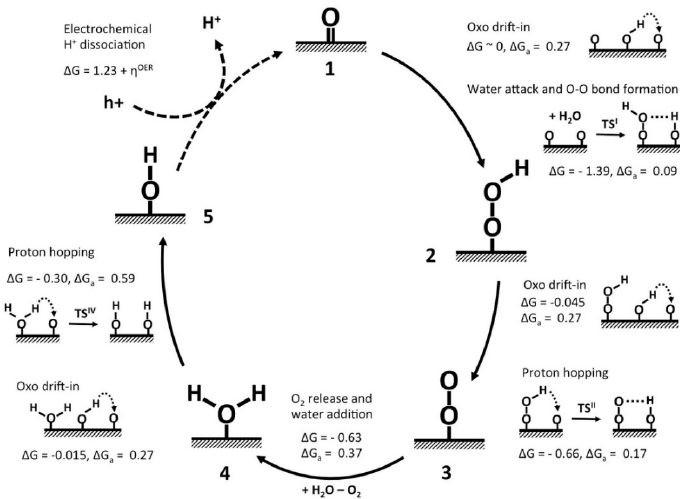
Figure 26. Proposed mechanism of oxidation catalysis by the water attack and proton hopping pathway. The Gibbs free energy reduction (Δ G ) and activation barriers (Δ G a ) of the evolution are given in eV. For simplicity, only one oxo site (where molecular oxygen evolves) is demonstrated in the big circle (intermediates 1 – 5 ). However, all calculations for water attack and proton jumping are performed with the assumptions that at least one adjacent oxo is available. In this scheme, only the Co III –OH to Co IV ═ O would be of electrochemical nature (requiring the transfer of an external hole). Other conversions (water addition and surface proton/electron hopping) are spontaneous (not electrochemical). (Reprinted from ref. [162] with permission from Journal of physical ACS Catalysis © 2014, American Chemical Society).